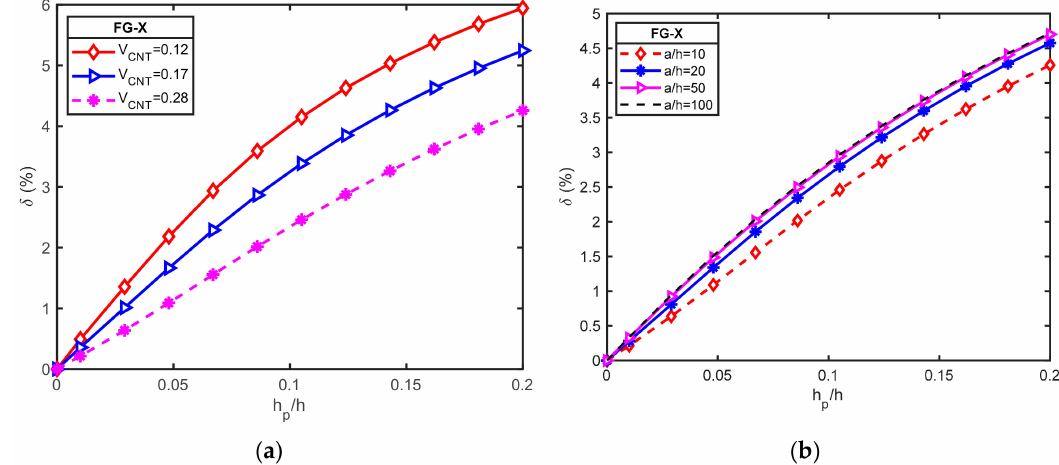
Figure 4. Variation of the natural frequency increment δ between O-circuit and C-circuit electrical conditionsversusthe h p / h ratioforasquarepiezoelectricfunctionallygradedcarbonnanotube-reinforced composite plates (PFG-CNTRC) plate ( a = b = 0.4 m; FG-X; [p / ( − 45 / 45) 3 / p]): ( a ) for di ff erent CNT volume fractions; ( b ) for di ff erent a / h